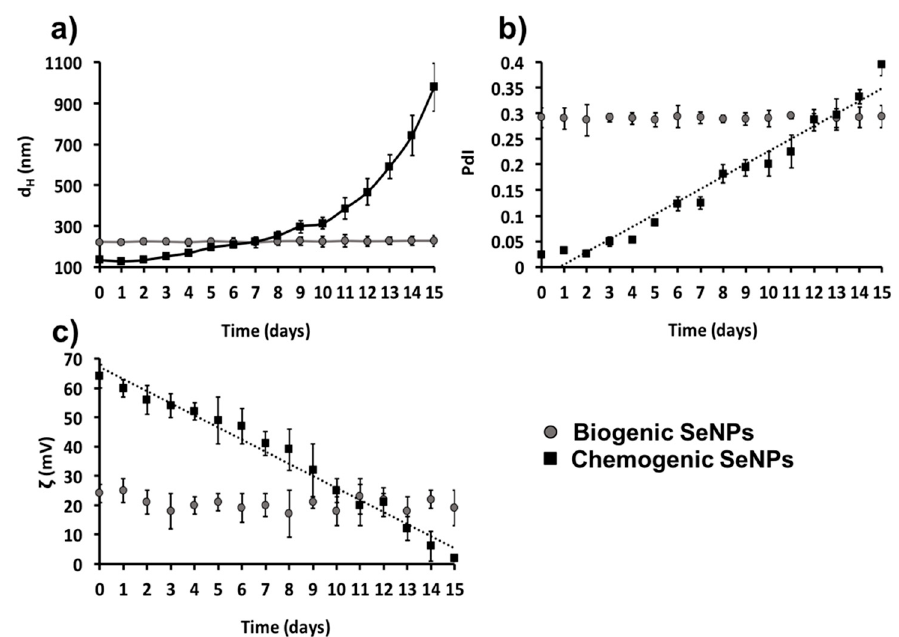
Figure 6. ( a ) Evaluation of the hydrodynamic diameter (d H ), ( b ) polydispersity index (PdI) values, and ( c ) zeta potential ( ζ ) absolute values of SeNPs MPV1-0.5_e and L -cys SeNPs incubated for 15 days at 27 °C. Linear relationships were observed between either ( b ) PdI or ( c ) ζ values of L -cys SeNPs and the incubation times ( R 2 = 0.96 and 0.97, respectively).